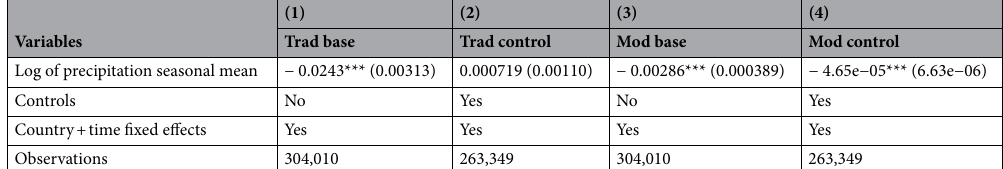
Table 4. Model estimated replacing drought indicator with natural log of precipitation. Clustered standard errors in parentheses ***p < 0.01, **p < 0.05, *p < 0.1.